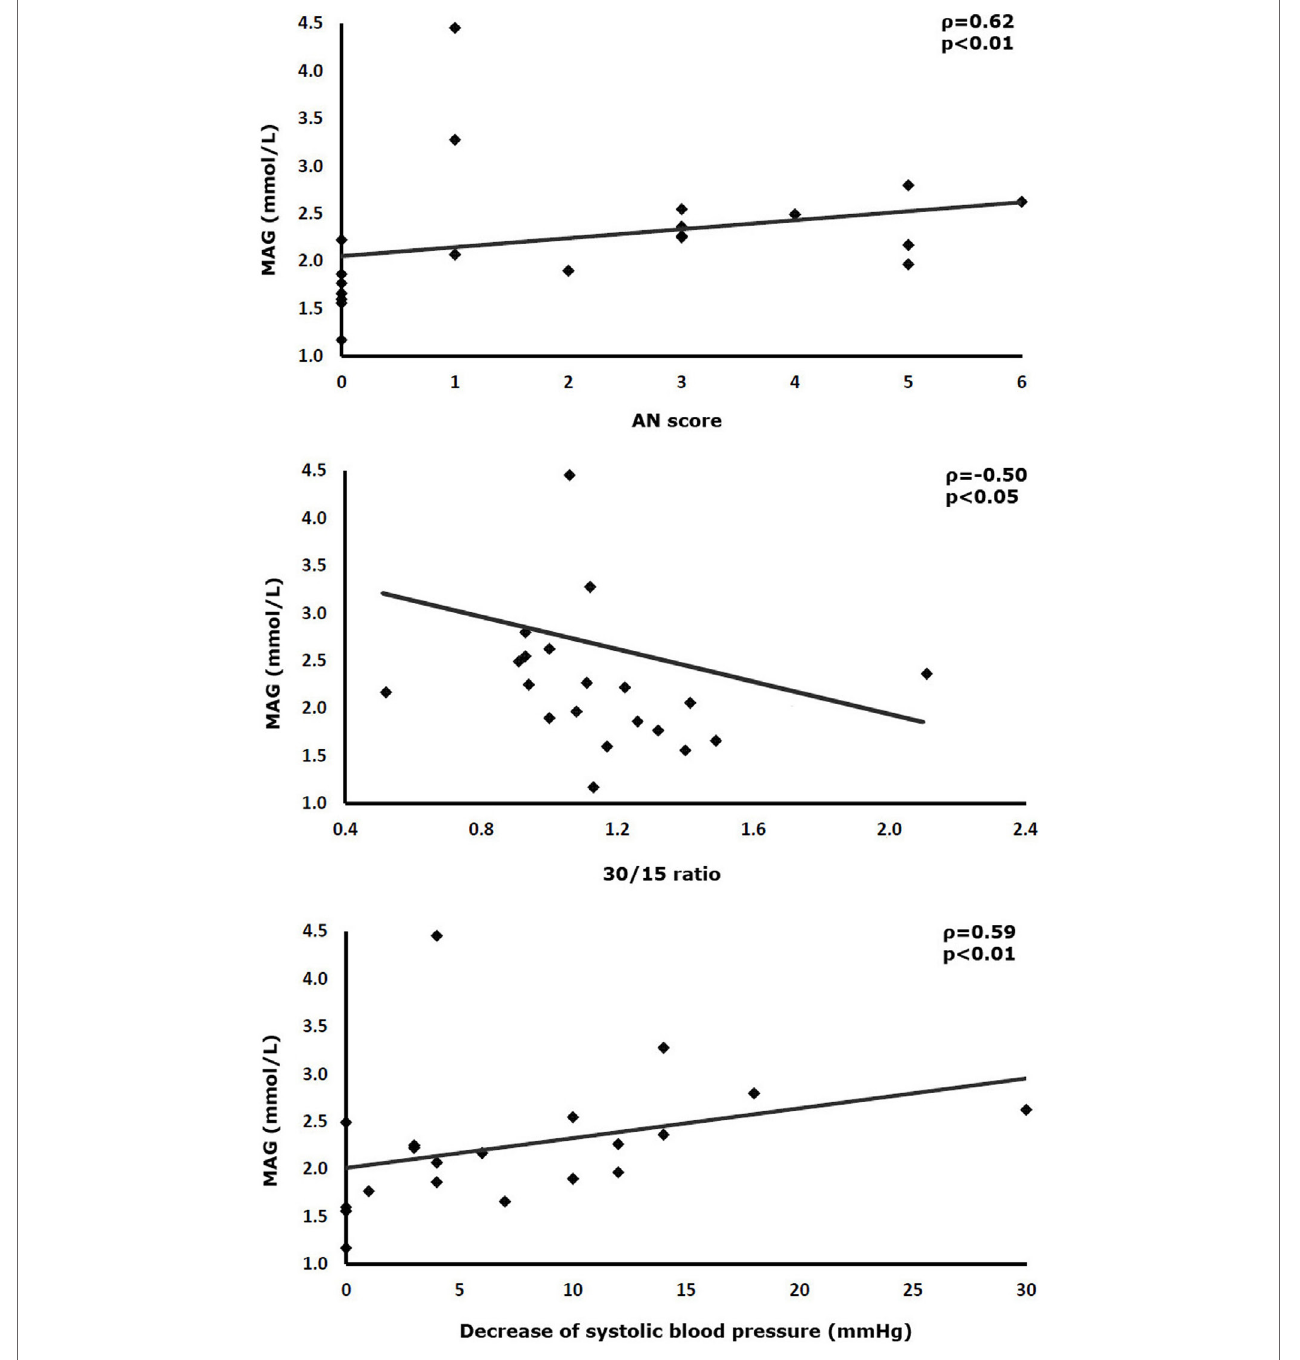
FigUre 2 | Correlations between the mean absolute glucose (MAG) of continuously measured interstitial glucose levels and cardiovascular reflex